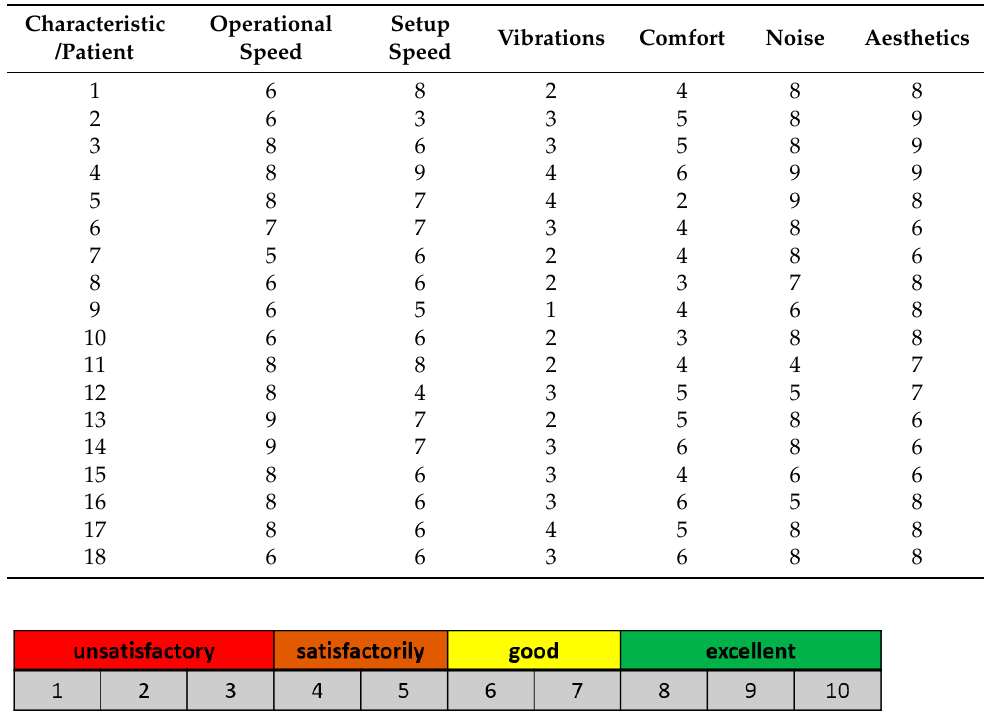
Table 4. Flexion/extension module.